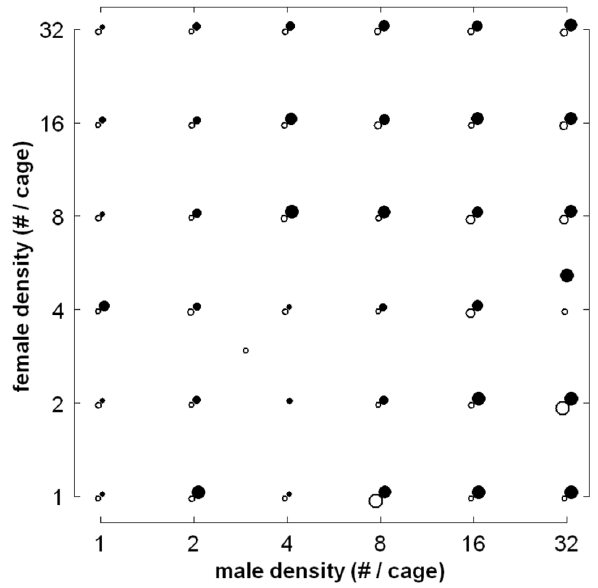
Figure 4. Proportion of female Leptinotarsa decemlineata fertilized at different combinations of male density and female density. Open and filled symbols depict single observations from short (3 h) trials and long (22 h) trials, respectively. Symbol size indicates the proportion of females fertilized, with the smallest and largest symbols corresponding to none and all of the females being fertilized, respectively. Long Tick marks indicate treatment levels. For represen- tational purposes, results of short trials and long trials have been slightly shifted diagonally. Note that in two trials (short M 4 ,F 2 and long M 32 ,F 4 ), treatment levels were not as intended; dissection proved one supposed male to be a female (see Appendix